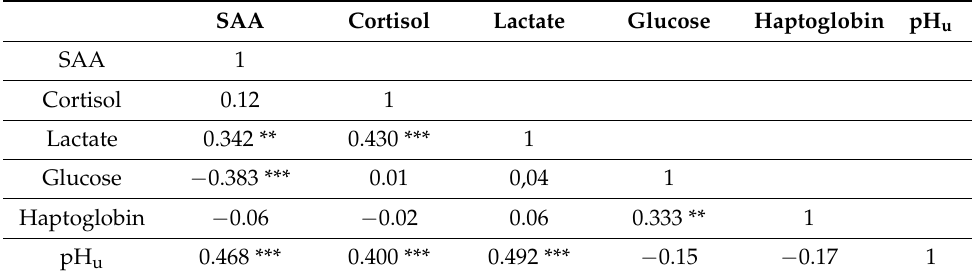
Table 2. Correlation coefficients among serum biomarkers at slaughter time and ultimate pH (pH u ). SAA Cortisol Lactate Glucose Haptoglobin pH u